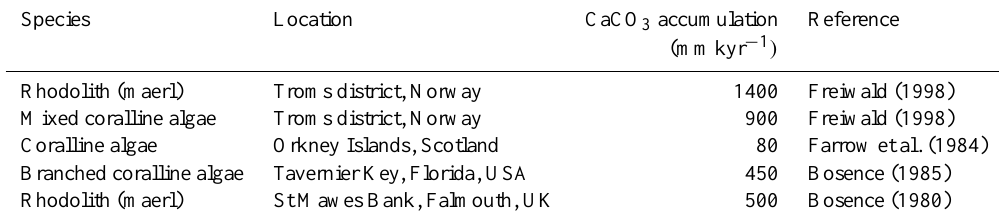
Table 5. Accumulation rates of free-living coralline algae. Coralline algae in Bosence (1985) were predominantly Neogoniolithon